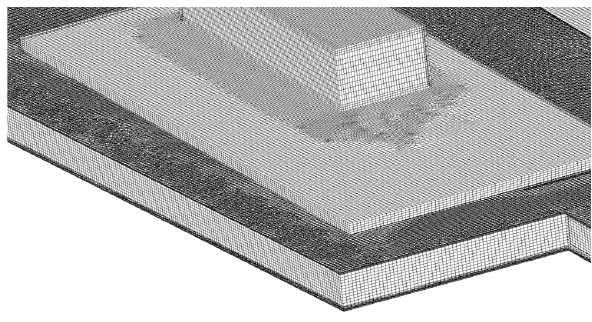
Figure 4. The surface mesh on the inner and outer parts